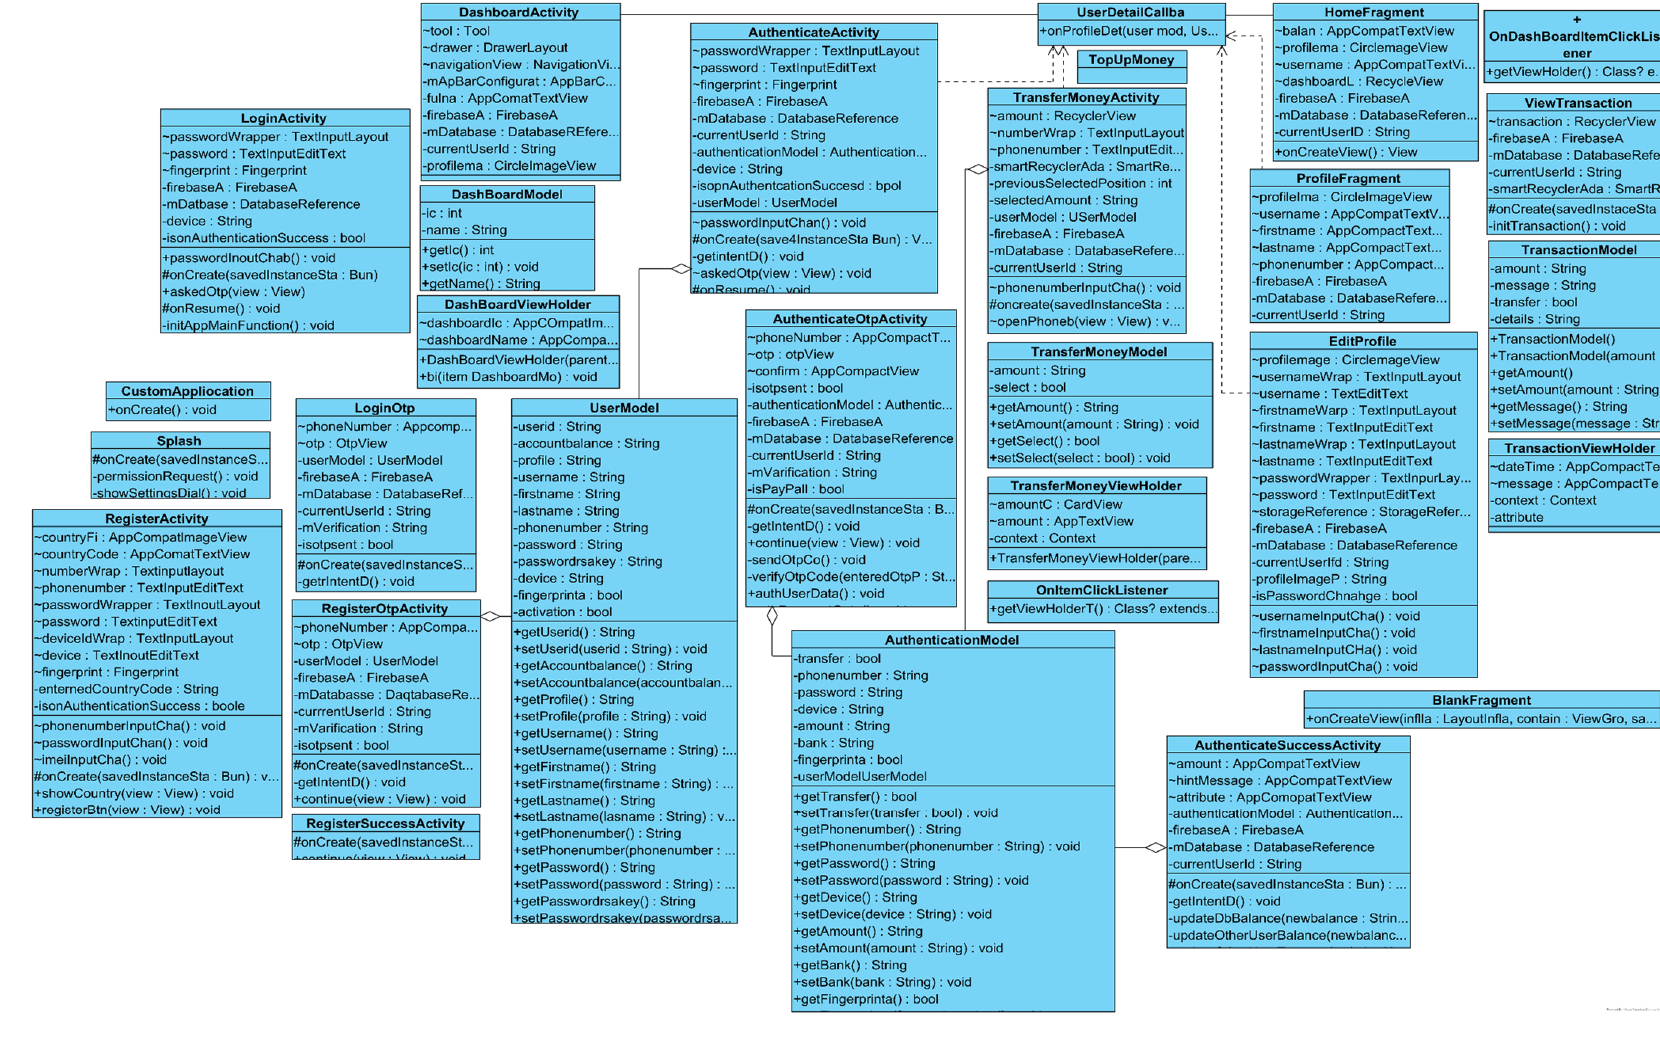
Figure 5. Class diagram of the entire proposed method.